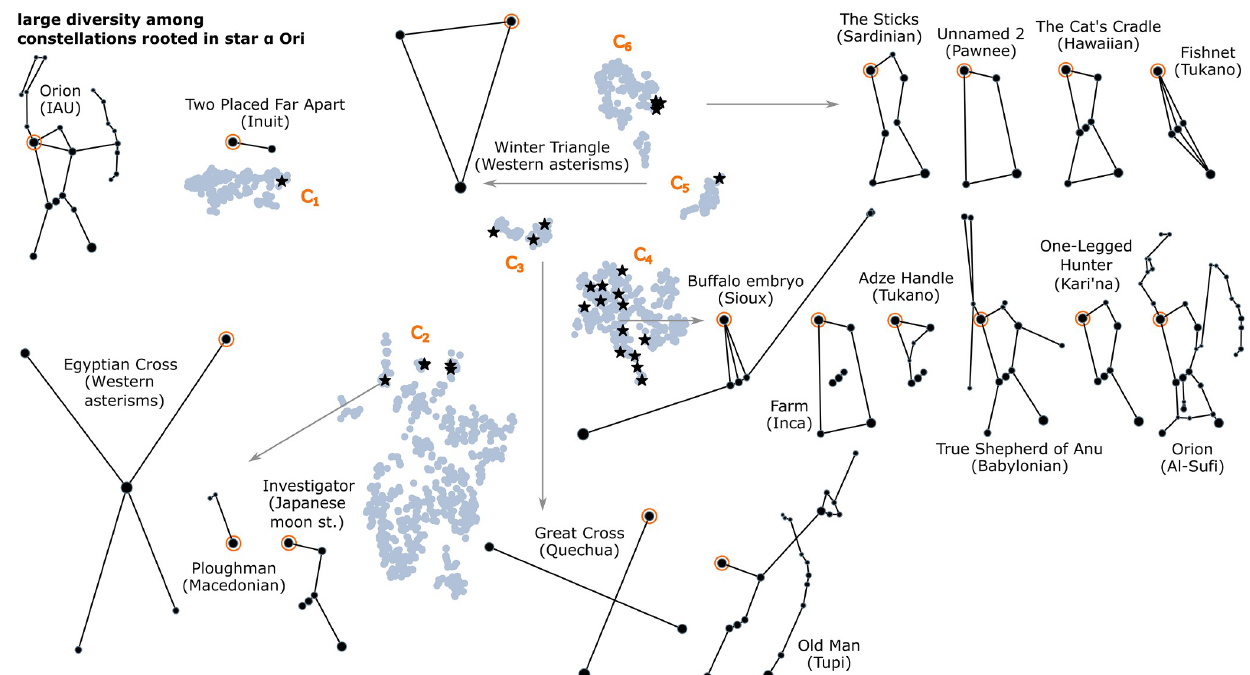
Fig 10. The diversity of constellations over the root star α Ori (II). In the background, in light blue, the embedding of all constellations. The IAU constellation Orion is shown at the top left, with α Ori emphasised. In the foreground, there are examples: black stars mark all constellations over α Ori, of which some are also shown, to